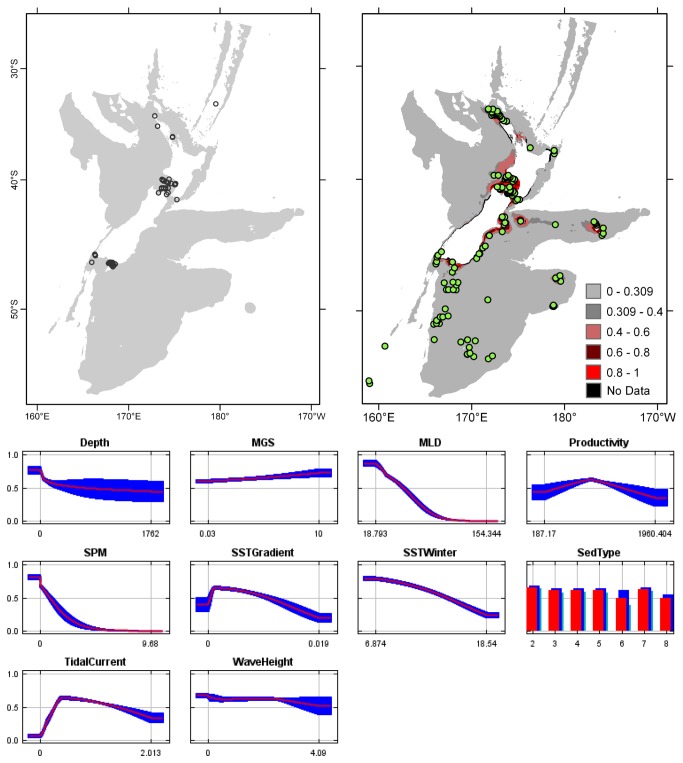

Diaperoecia

purpurascens
 known distribution (left), predicted suitable habitat (right), and fitted responses curves (marginal).For the predicted distribution, logistic probabilities less than the 10th percentile presence value indicated cells were unsuitable habitat. Probabilities of 0.4–0.6 indicated habitat suitability typical of the presence records, values of 0.6–0.8 and 0.8–1 indicated favourable and highly suitable habitat, respectively. Black cells had missing data in one or more environmental layer. Independent records are layed over the predictions. Marginal response curves show how the prediction changes for different values of each variable when all other variables were at their average sample value. Individual response curves are shown in Figure S3. For the categorical variable Sediment type: 1 = deep ocean clays; 2 = calcareous gravel; 3 = volcanic; 4 = calcareous mud; 5 = gravel; 6 = mud; 7 = sand; 8 = calcareous sand.